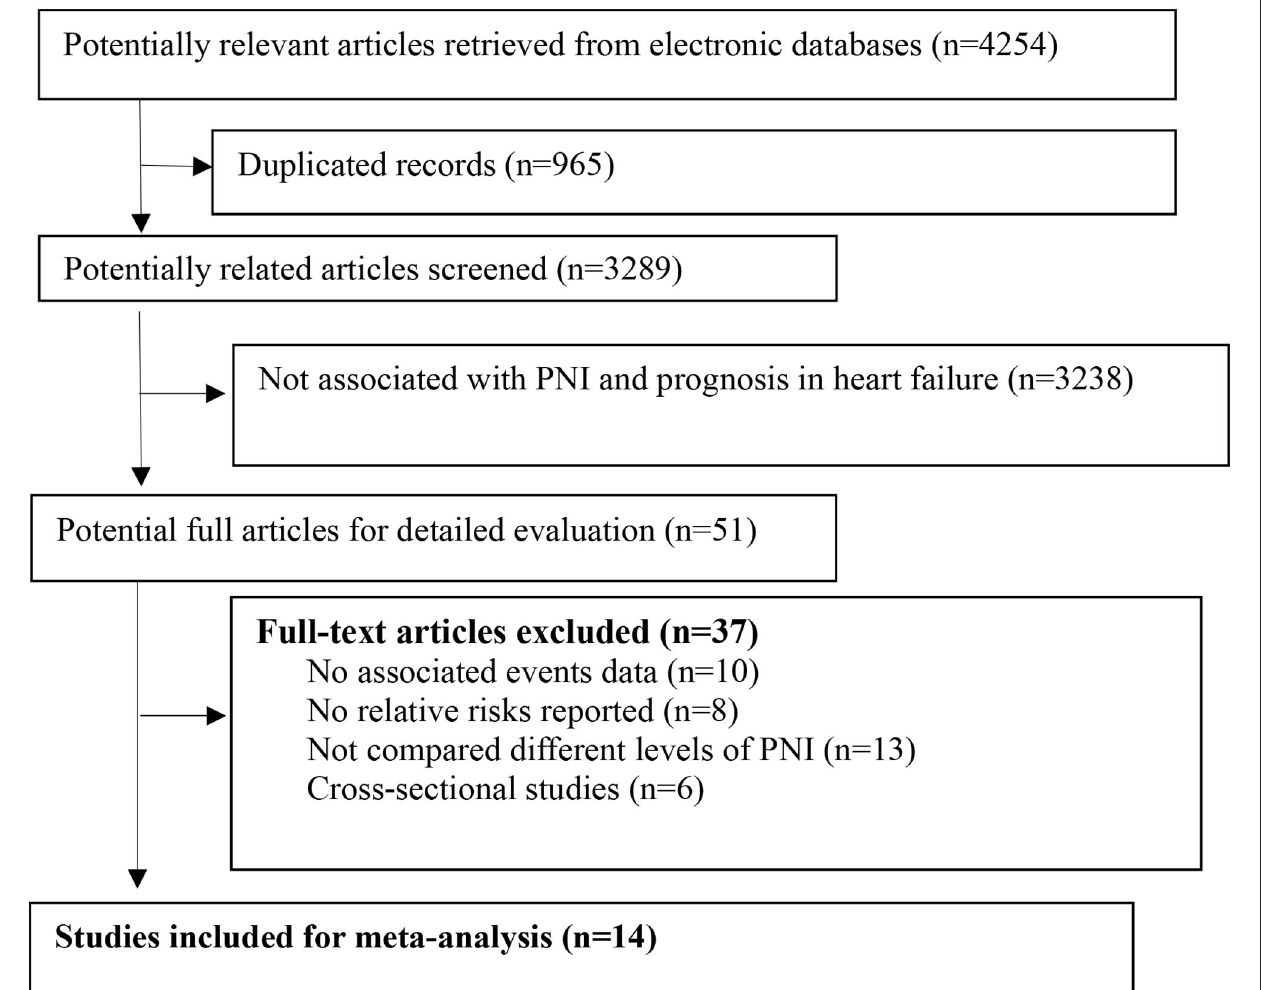
FIGURE 1 | Flow of papers through review. PNI, prognostic nutritional index.